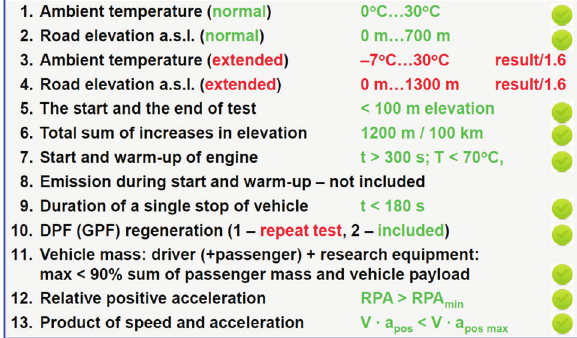
Fig. 3. Specific requirements of the test drive cycle [3]